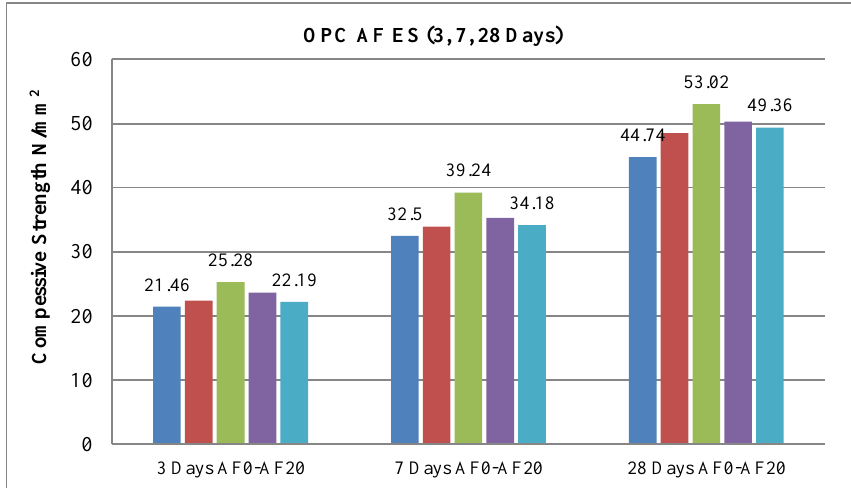
Figure 11. Comparative cube compressive strength at 3, 7, 28 days.